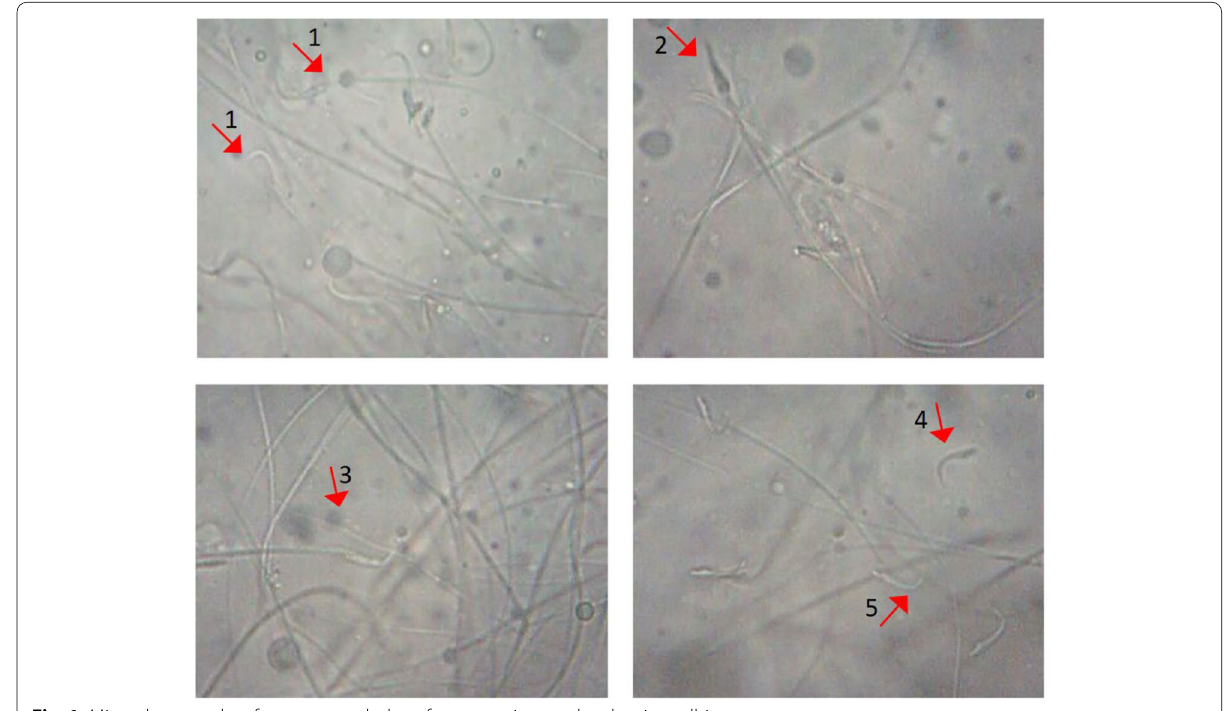
Fig. 1 Microphotographs of semen morphology from experimented male wistar albino rats 1-Normal morphology; Abnormal morphology includes 2-Pairing phenomenon; 3-Headless tail; 4-Detached head and 5-Bend